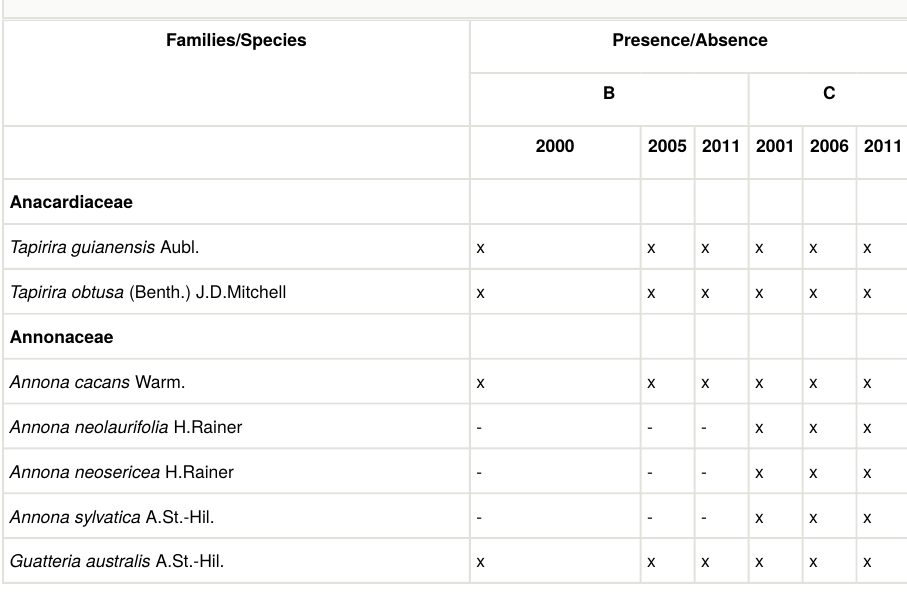
Families and species: presence and absence in the stands B and C of the Semideciduous Atlantic Forest at Parque Ecológico Quedas do Rio Bonito (PEQRB), municipality of Lavras, South of Minas Gerais State, Southeast